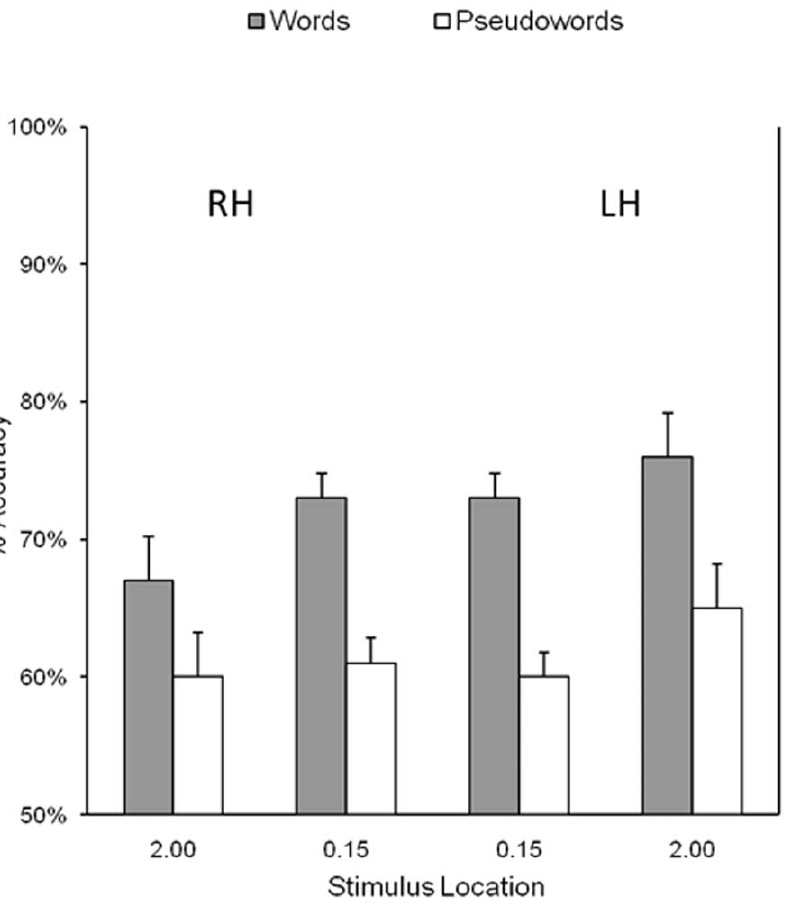
Figure 2. Results for Experiment 1. Footnote: Mean identification accuracy for Arabic words and pseudowords displayed at foveal and extrafoveal locations in Experiment 1. Bars correspond to 95% confidence intervals [78]. The terms RH and LH refer to the hemisphere contralateral to the hemifield in which stimuli were presented.